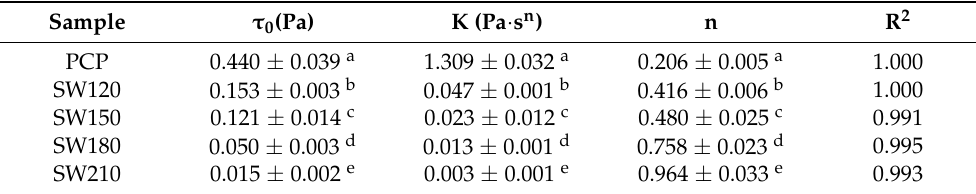
Table 1. Herschel–Bulkley model parameters of polysaccharides solutions (0.1 g/mL) under different SCW